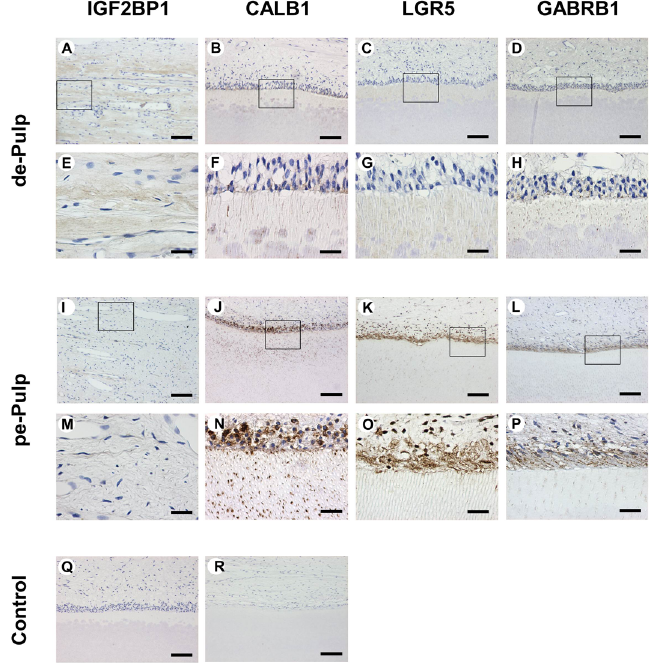
Figure 4. IHC staining of deciduous dental pulp tissues (A-H) and permanent dental pulp tisseus (I–P). IHC staining for IGF2BP1 in deciduous dental pulp tissue (A, E) and permanent dental pulp tissue (I, M). IHC staining for CALB1 in deciduous dental pulp tissue (B, F) and permanent dental pulp tissue (J, N). IHC staining for GABRB1 in deciduous dental pulp tissue (D, H) and permanent dental pulp tissue (L, P). Negative control staining in deciduous dental pulp tissue (Q) and permanent dental pulp tissue (R). The micrographs in E–H and M–P are higher-magnification views of the areas outlined by squares in A–D and I-L, respectively. Abbreviations: de-Pulp, deciduous dental pulp tissue; pe-Pulp, permanent dental pulp tissues. Scale bars: 100 m m in A–D, I–L, and Q–R; 25 m m in E–H and